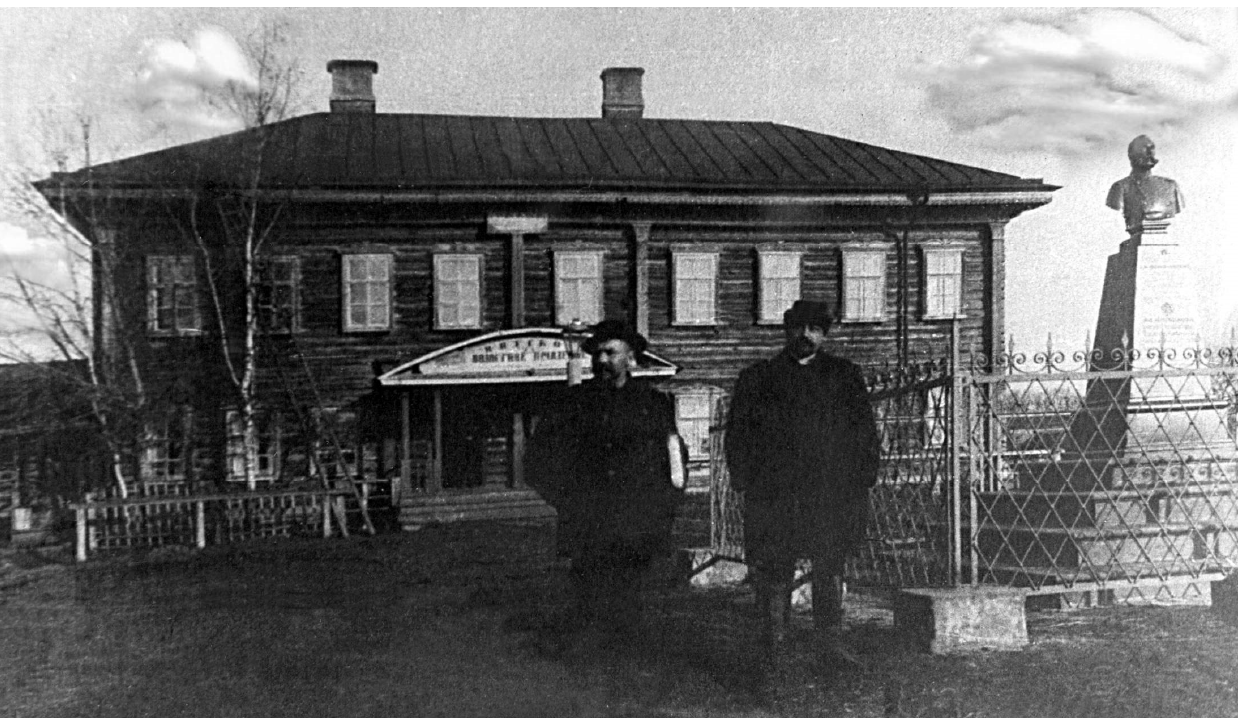
Figure 3. The Volost’ administration building in the village of Vyatsk in the early 1900s. In front, a monument to Emperor Alexander II is clearly visible. Today, it has been